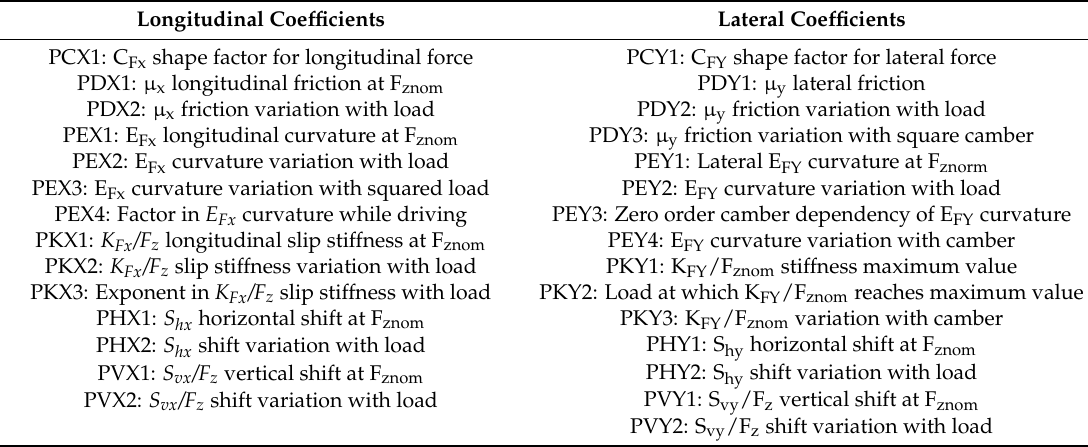
Table 1. Pacejka’s Magical Formula coefficient